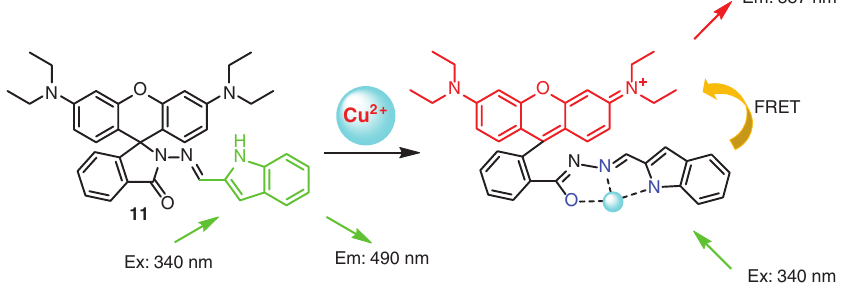
Figure 9: Cu 2 + -induced FRET OFF → ON of probe 11 .